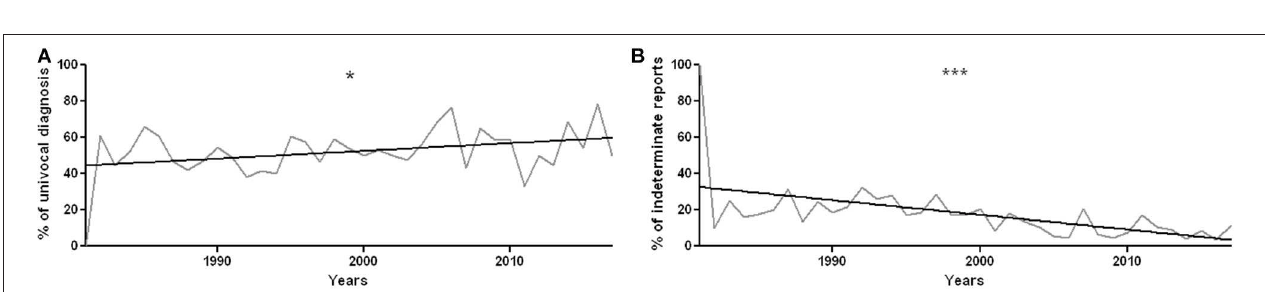
FIGURE 3 | (A) Average age of patients undergoing sural nerve biopsy during each year from 1981 to 2017. The increase in mean age is statistically significant with r 2 = 0.64 and p < 0.0001. (B) Percentage of minors compared to all the patients undergoing sural nerve biopsy year by year. The decrease in the percentage of biopsies performed on minors is statistically significant, with r 2 = 0.35 and p = 0.0001. *** p < 0.001.